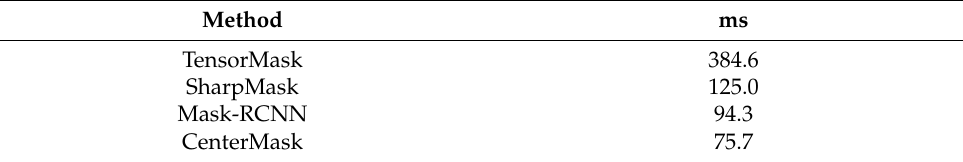
Table 5. Comparison of inference time of pixel-level detection-based methods.